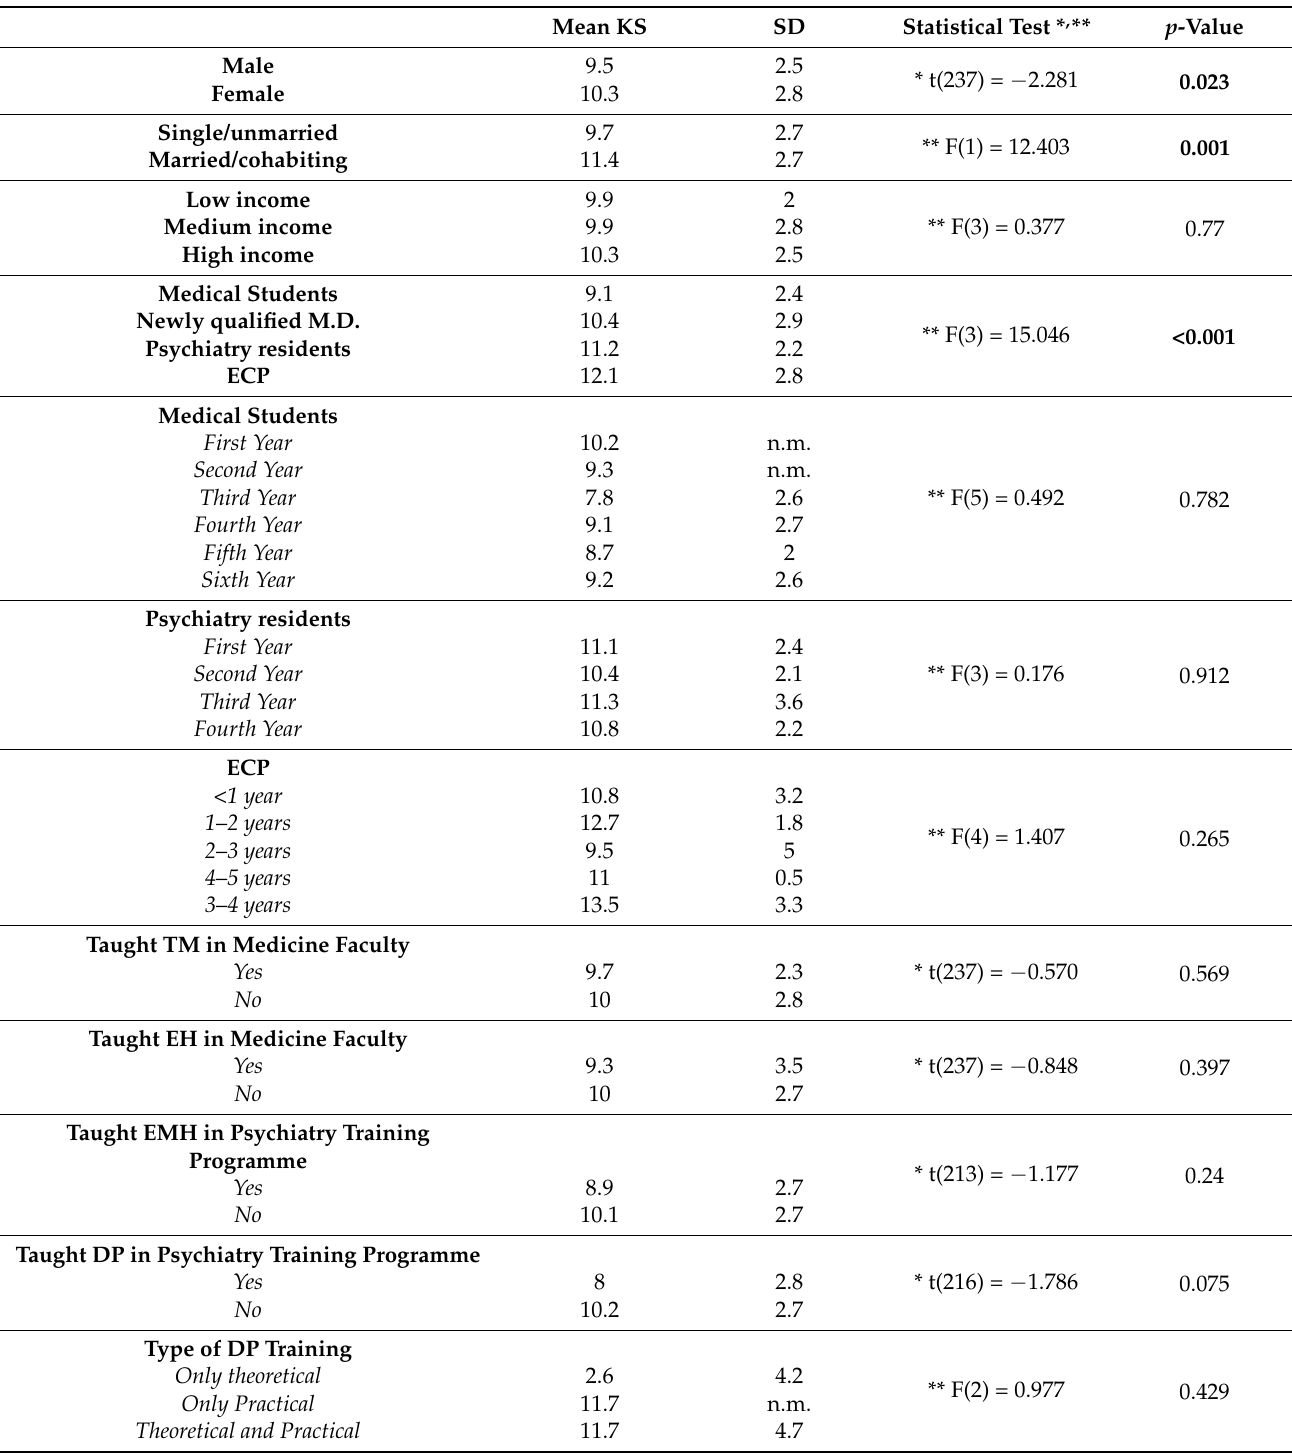
Table 4. Knowledge Score according to socio-demographic and training